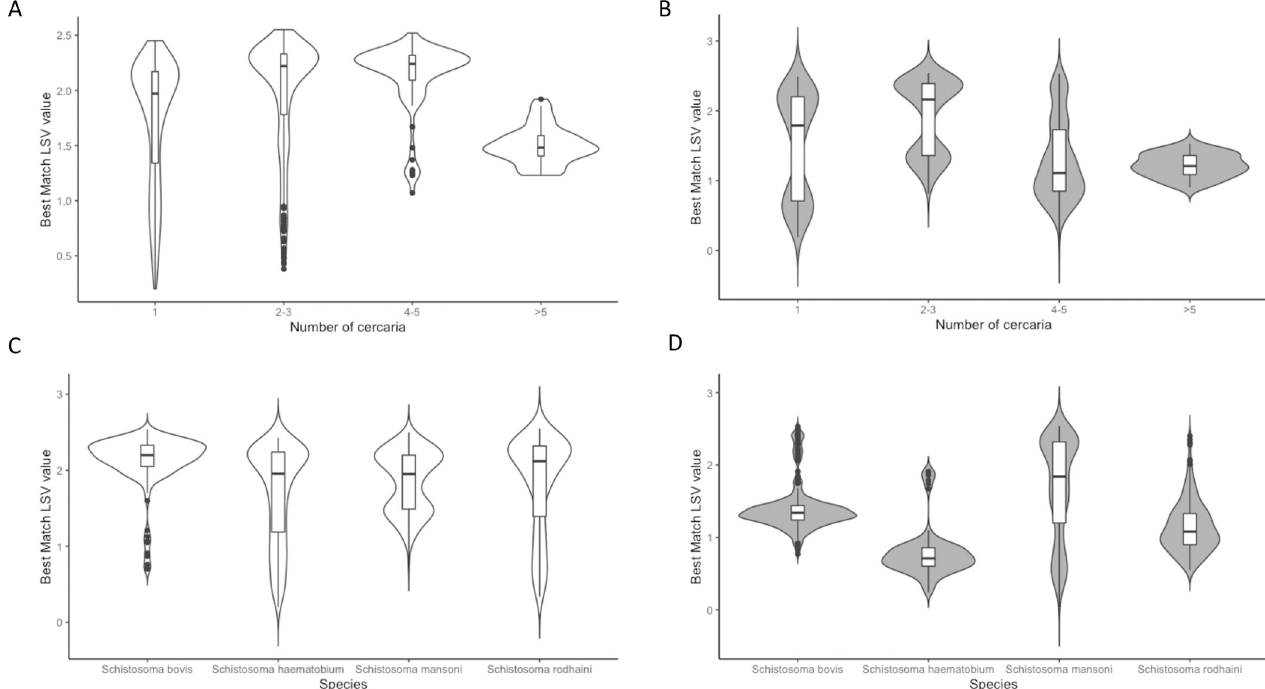
Fig 5. Influence of ethanol preservation, number of deposited cercariae and species on LSV. Violins plot of best match LSV value for: A. Fresh specimens according to the number of deposited spectra. B. Ethanol preserved specimens according to the number of deposited spectra. C. Fresh specimens according to the species. D. Ethanol preserved specimens according to